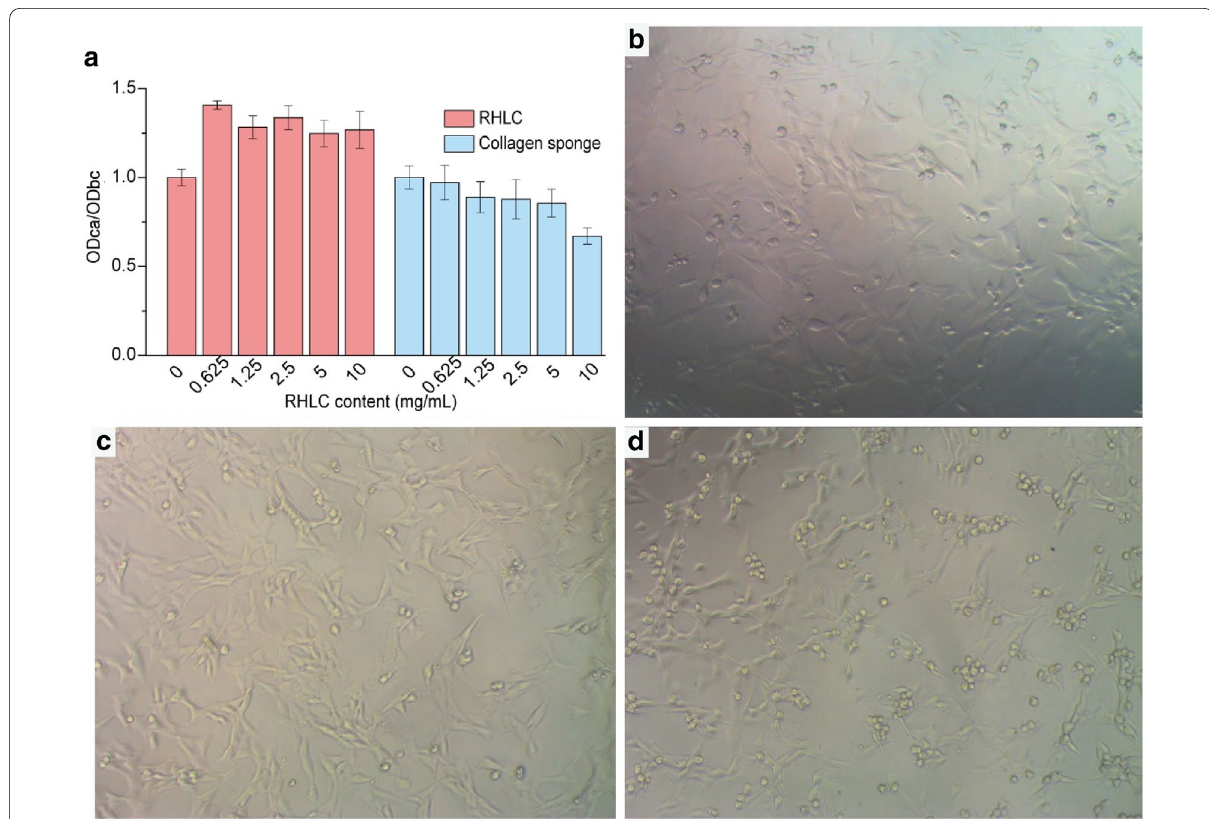
Fig. 4 In vitro cytotoxicity evaluation of RHLC (200 ). a OD CA /OD BC values of CA groups. b BC cells after adding fresh culture medium; c CA cells × after adding 10 mg/mL RHLC; d CA cells after adding 10 mg/mL collagen